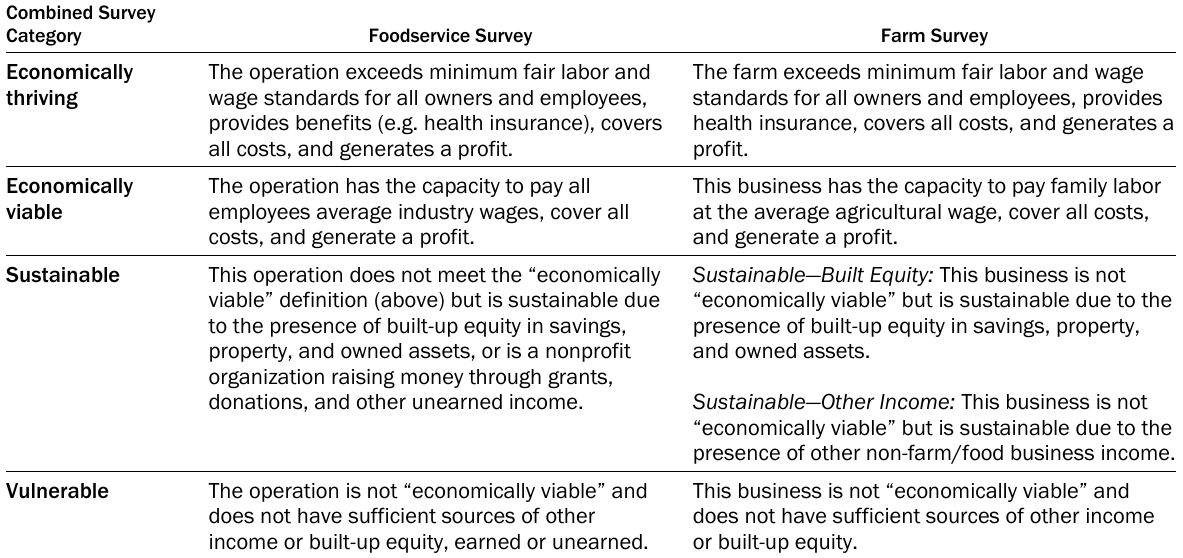
Table 1. Financial Status Definitions Across Both Surveys Combined Survey